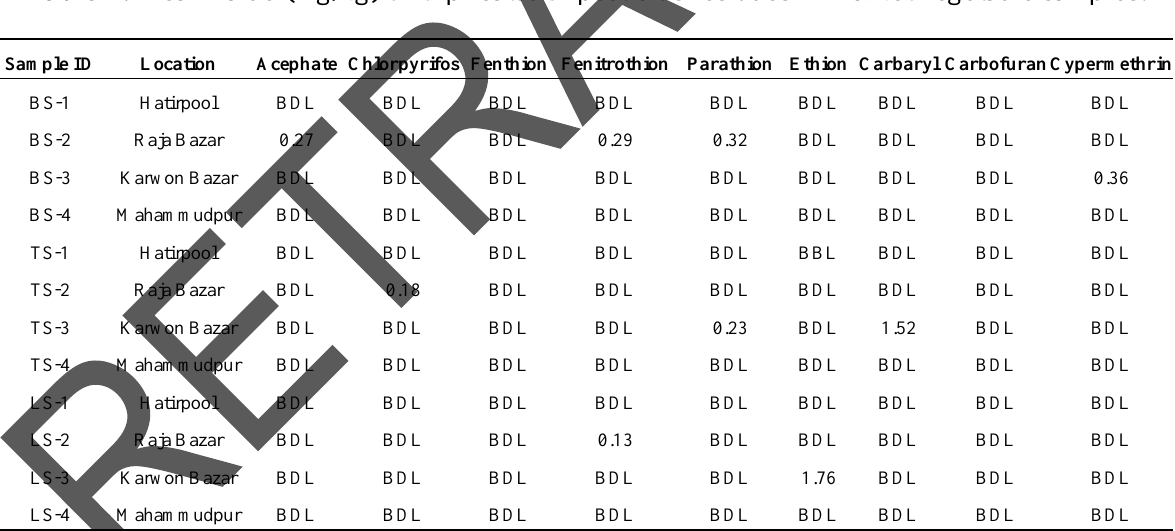
Table 2. Mean value (mg/kg) of triplicates of pesticide residues in market vegetable samples. Sample ID